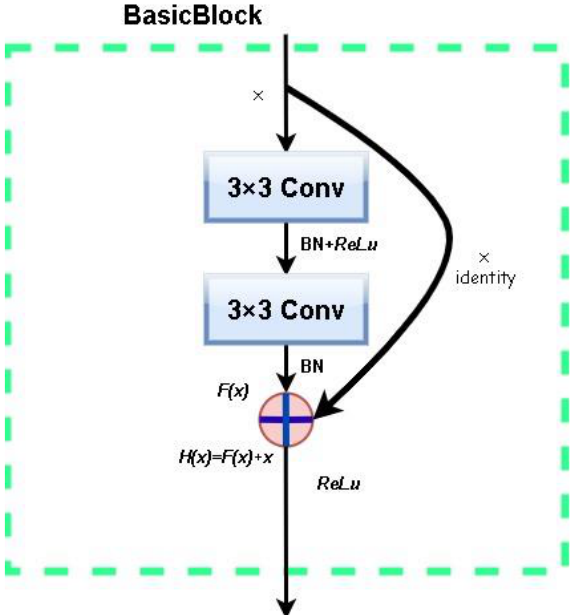
Figure 2. ResNet residual learning module.